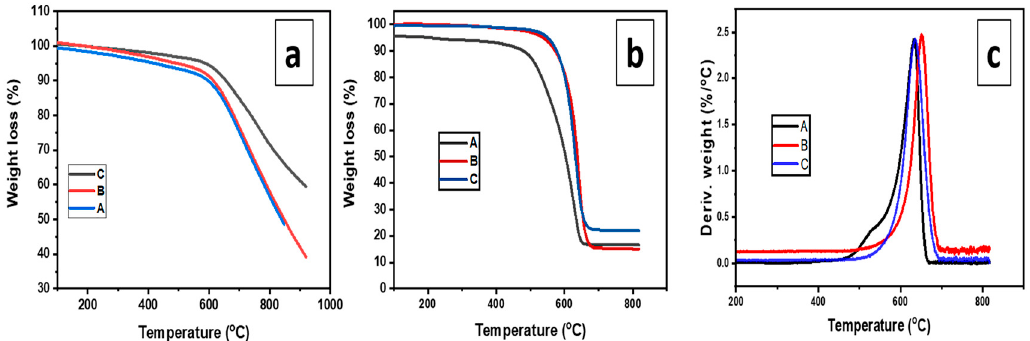
Figure 11. Thermogravimetric analysis (TGA) and Di ff erential Thermal analysis (DTG) curves of as-produced CNTs deposited over NiMo / CaTiO 3 catalyst prepared at di ff erent calcination temperatures: A = 600 ◦ C, B = 700 ◦ C, and C = 800 ◦ C: ( a ) under N 2 ; ( b ) under O 2 , and ( c ) DTG under O 2 atmosphere.